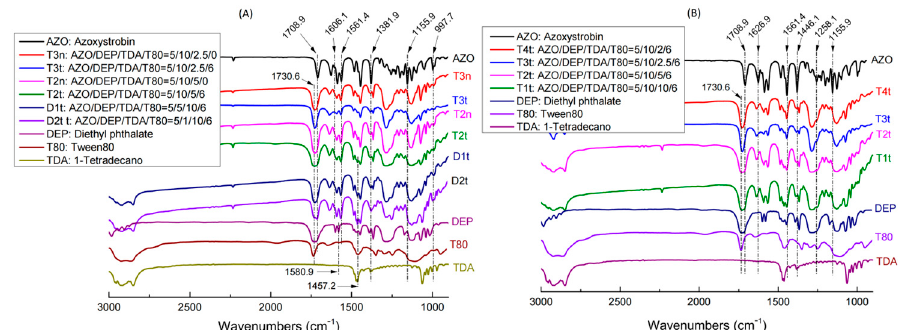
Figure 3. Comparison of FTIR peaks from oil-phase samples. The influences of DEP and T80 are shown in ( A ), and the effect of TDA is shown in ( B ).